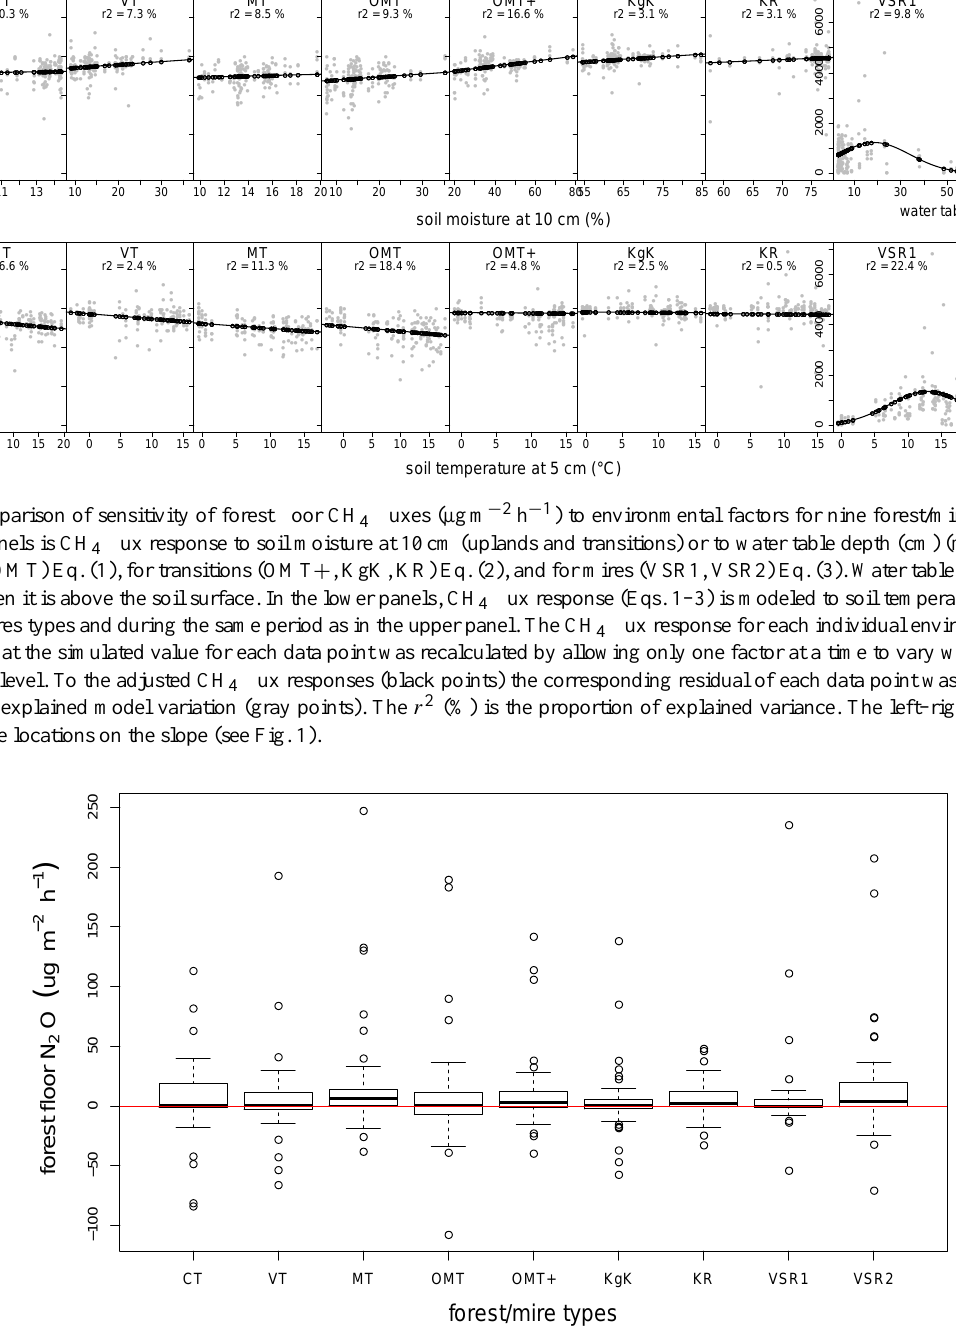
Figure 5. The box plot of forest floor N 2 O fluxes (µgm − 2 h − 1 ) for each forest/mire type (uplands – CT, VT, MT, OMT; transitions – OMT + , KgK, KR; and mires – VSR1, VSR2) during the period including typical and dry years. The left–right arrangement of sites mimics the locations on the slope (see Fig.